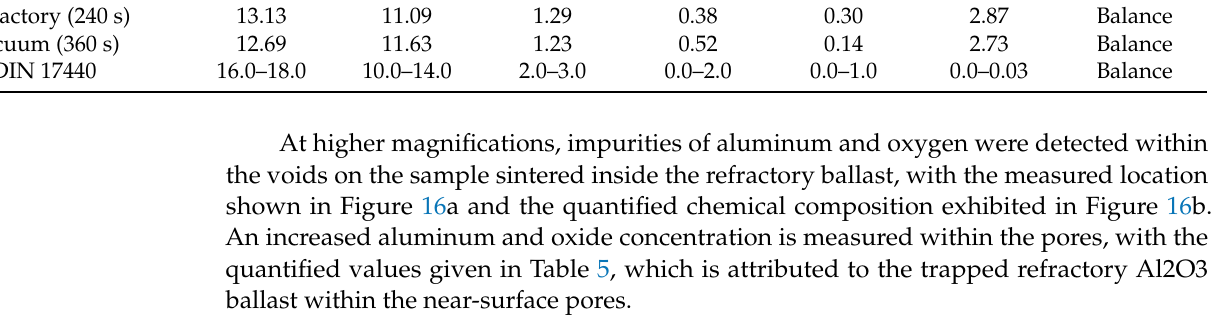
Table 4. Chemical composition of geometries sintered in the refractory ballast and vacuum, wt. %. Cr Ni Mo Mn Si C Fe